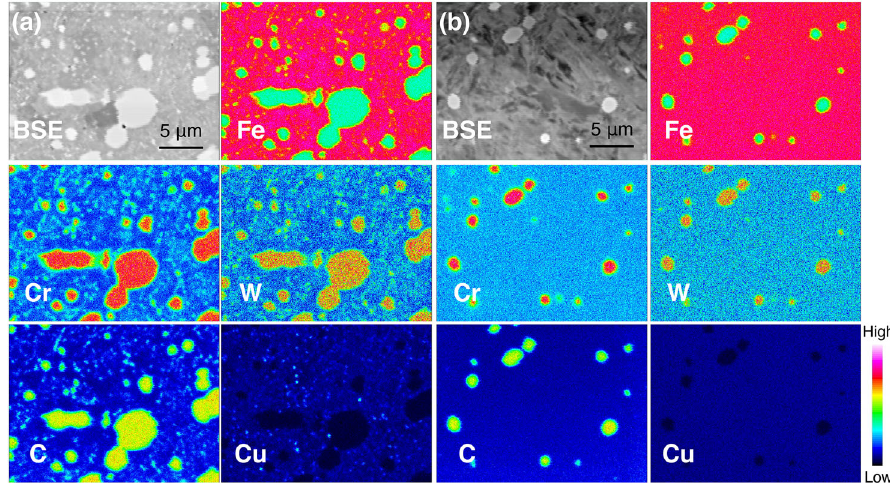
Fig. 2 Elemental distributions of the developed steels obtained at different heat treatment temperatures. SEM-BSE images and the corresponding EPMA elemental maps of the 16Cr steels heat treated at a 800 and b 1100